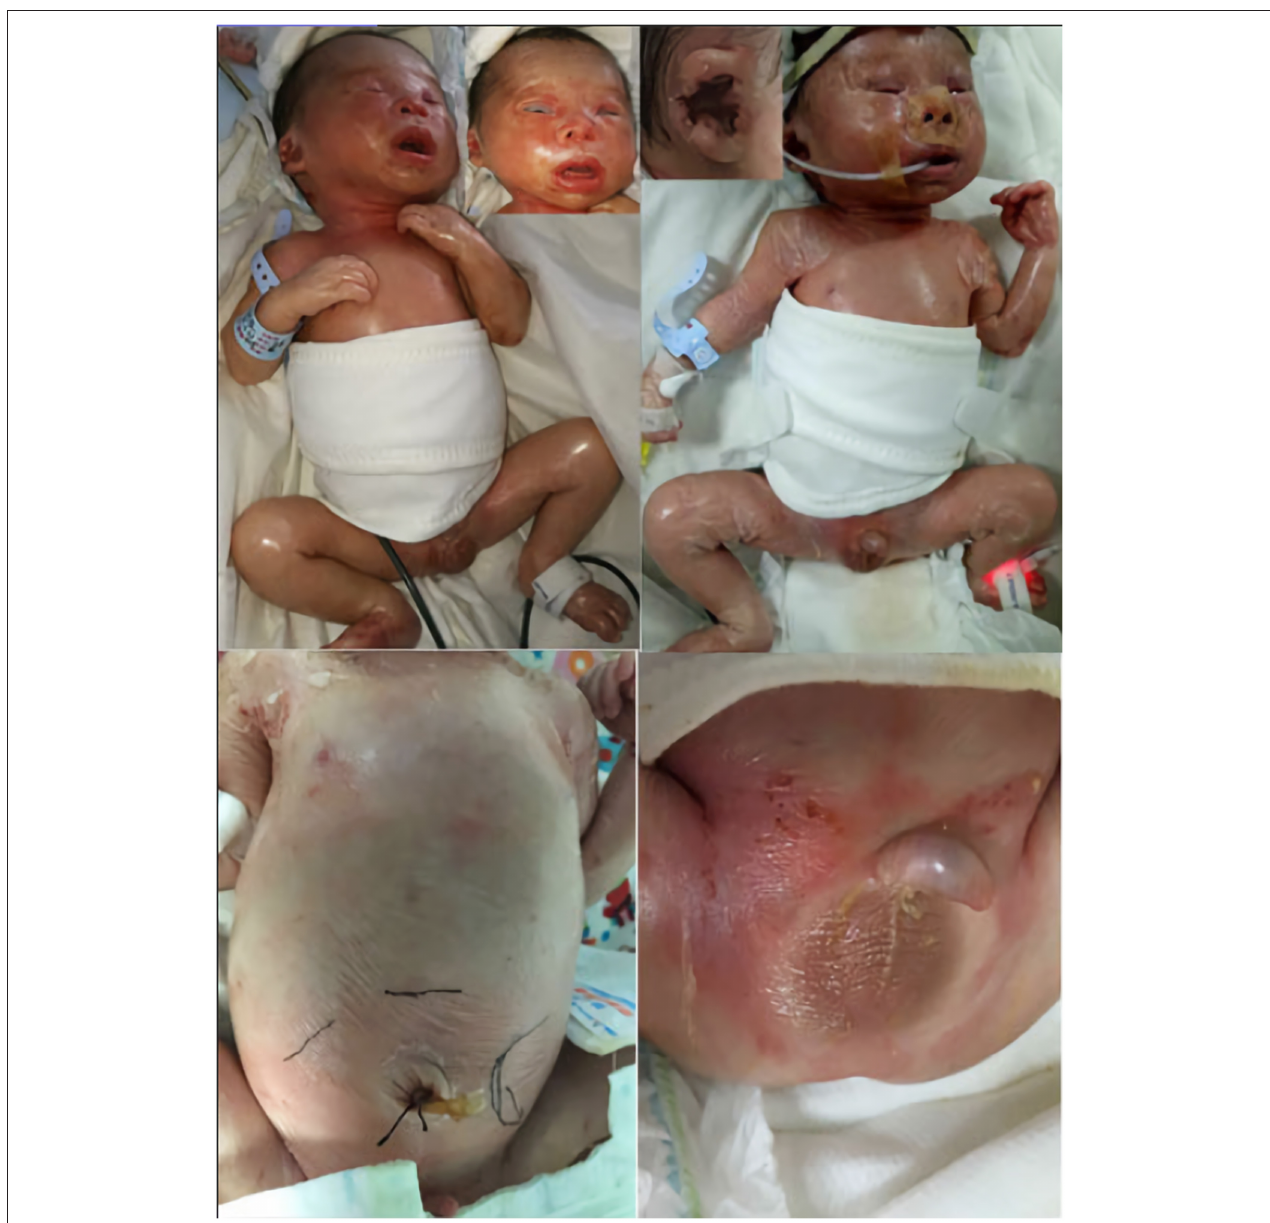
FIGURE 2 | Clinical phenotype: facial dysmorphia; pinna development deformity; ichthyosis, joint contractures, anasarca; peeling skin on limbs and groin. The black line shows the boundaries of the liver and spleen, indicating hepatosplenomegaly; small microcaulia.